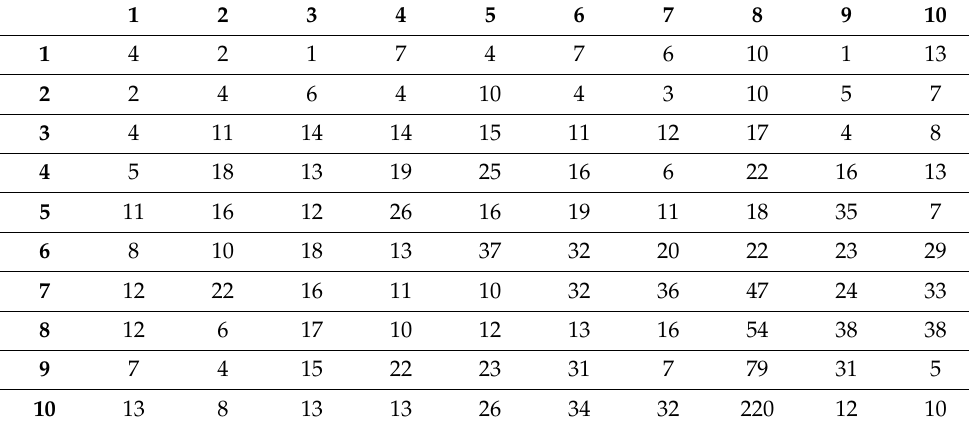
Table 5. The number of companies in individual clusters for the year